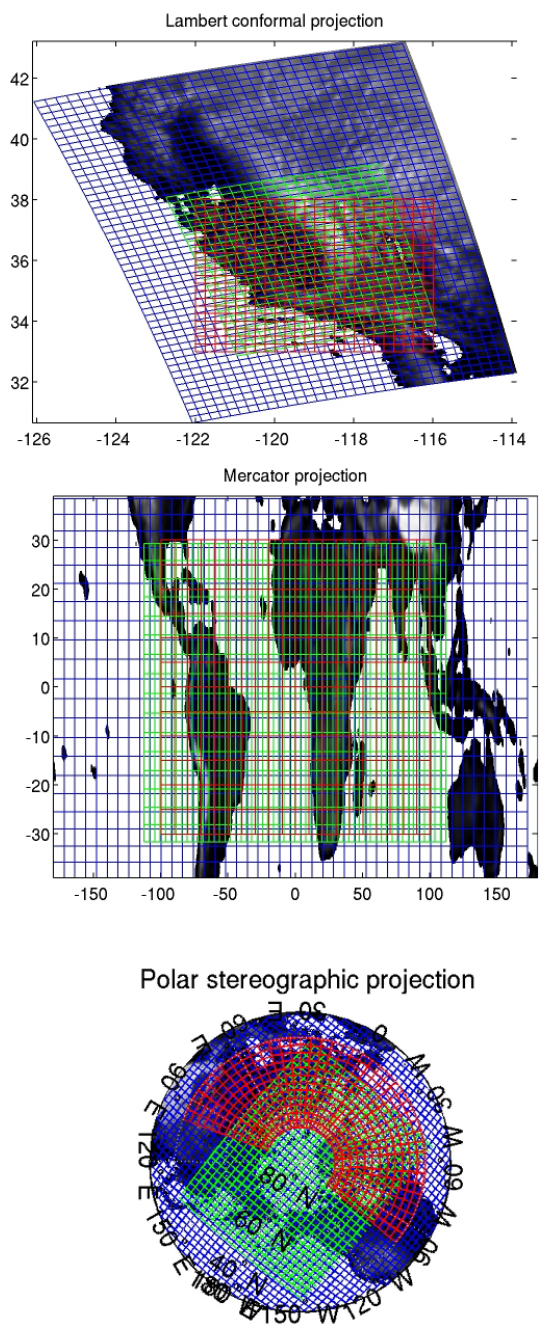
Fig. 1. Lambert conformal, Mercator and polar stereographic pro- jections from WRF (blue grid). Two types of projection can be de- fined for the FLEXPART output: A projection that follows the WRF projection output (green grid), the so-called irregular output grid, and a projection based on regular latitude/longitude coordinates (red grid), the so-called regular grid. See Sect. 2.7 for further details on the FLEXPART output.